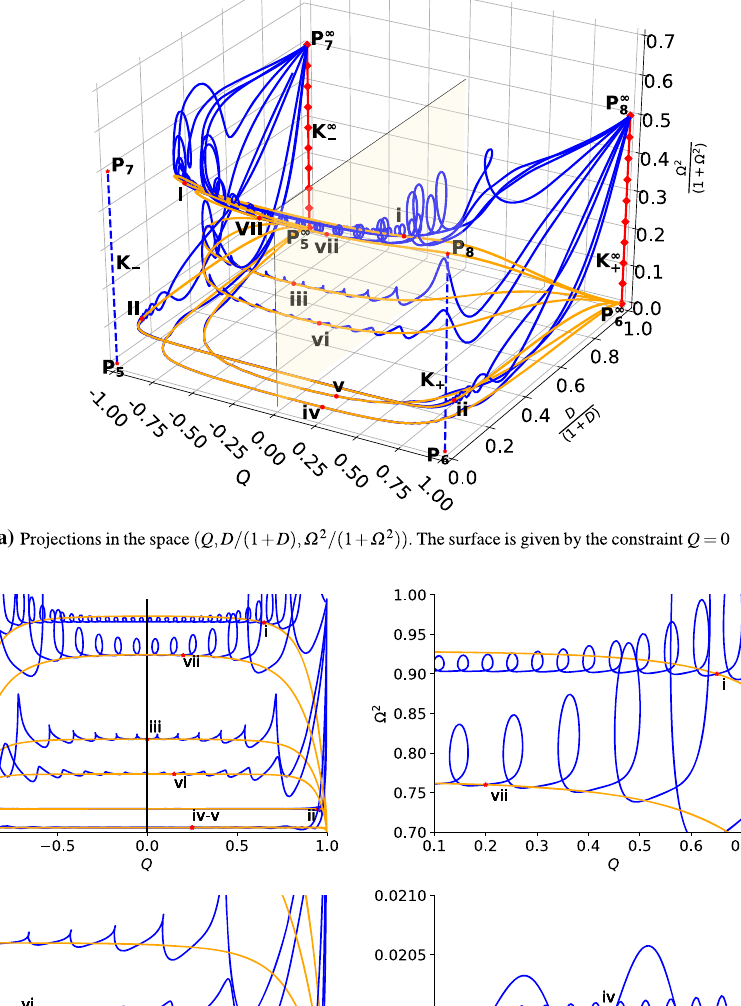
Fig. 22 Some solutions of the full system (118) (blue) and time-averaged system (151) (orange) for the FLRW metric with positive curvature ( k = + 1) when γ = 1. We have used for both systems the initial data sets presented in Table